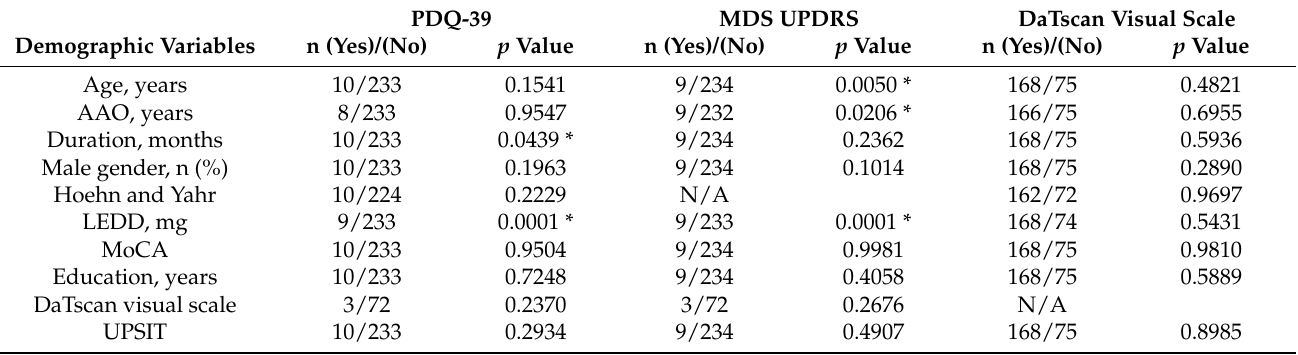
Table A1. Comparisons of demographic variables in data-missing group and data-available group. PDQ-39 MDS UPDRS DaTscan Visual